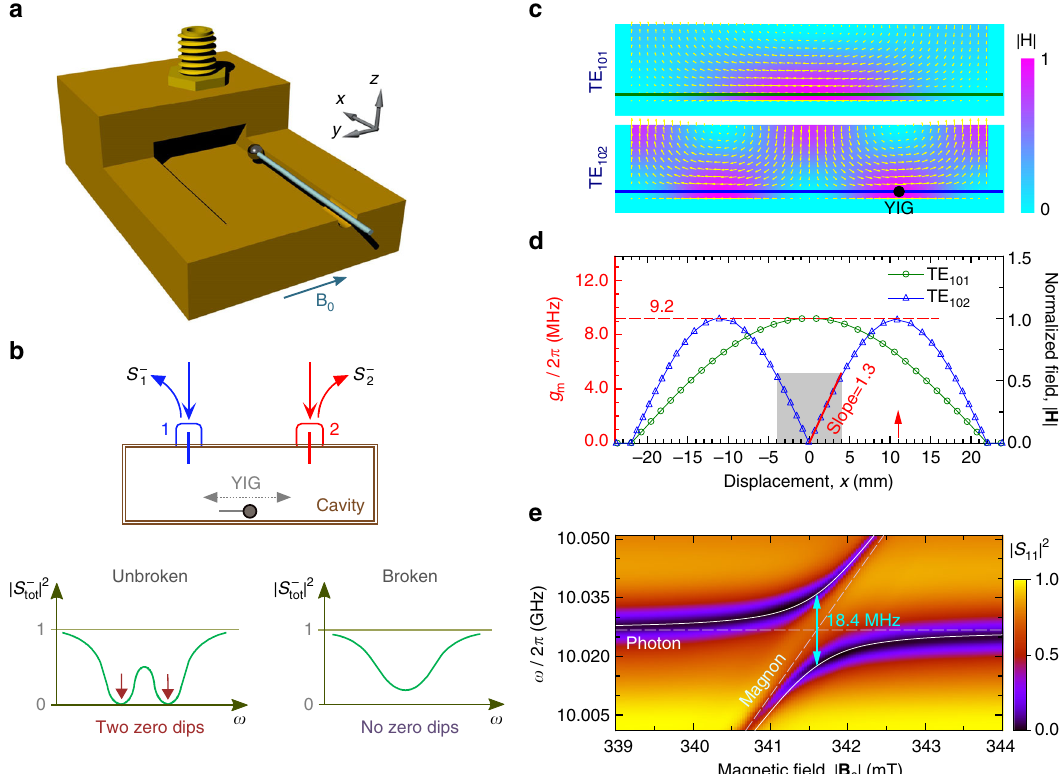
Fig. 1 Cavity magnon – polaritons. a Sketched structure of the cavity magnon – polariton system, where a YIG sphere glued on a wooden rod is inserted into a 3D rectangular cavity through a hole of 5 mm in diameter in one side of the cavity. The displacement of the YIG sphere can be adjusted along the x direction using a position adjustment stage and the static magnetic fi eld is applied along the y direction. The cavity has two ports for both measurement and feeding microwave fi elds into the cavity. b Diagram of the cavity magnon – polariton system with two feedings. The total output spectrum S (cid:1) (cid:1) (cid:1) (cid:1) (cid:1) (cid:1) (cid:1) 2 from port 1 and S (cid:1) (cid:1) (cid:1) 2 from port 2. When the system is designed to possess PT symmetry as described by Eq. (2), there is an sum of output spectrum S (cid:1) 1 2 exceptional point. In the unbroken-symmetry regime, the total output spectrum has two coherent perfect absorption (CPA) frequencies, but no CPA occurs in the broken-symmetry regime. c Normalized microwave magnetic- fi eld distributions of the cavity modes TE 101 and TE 102 . d Variations of the microwave magnetic fi elds of the TE 101 and TE 102 modes along the moving path of the YIG sphere marked in c . The gray area corresponds to our experimental region, where the magnetic- fi eld intensity of the TE 102 mode shows an approximately linear relation with the displacement of the YIG sphere and the varying slope is estimated to be 1.3 MHz/mm. e The maximal coupling of the TE 102 mode to magnon is reached at the displacement x j j (cid:3) 11 mm of the YIG sphere, with the fi tted coupling strength given as 9.2